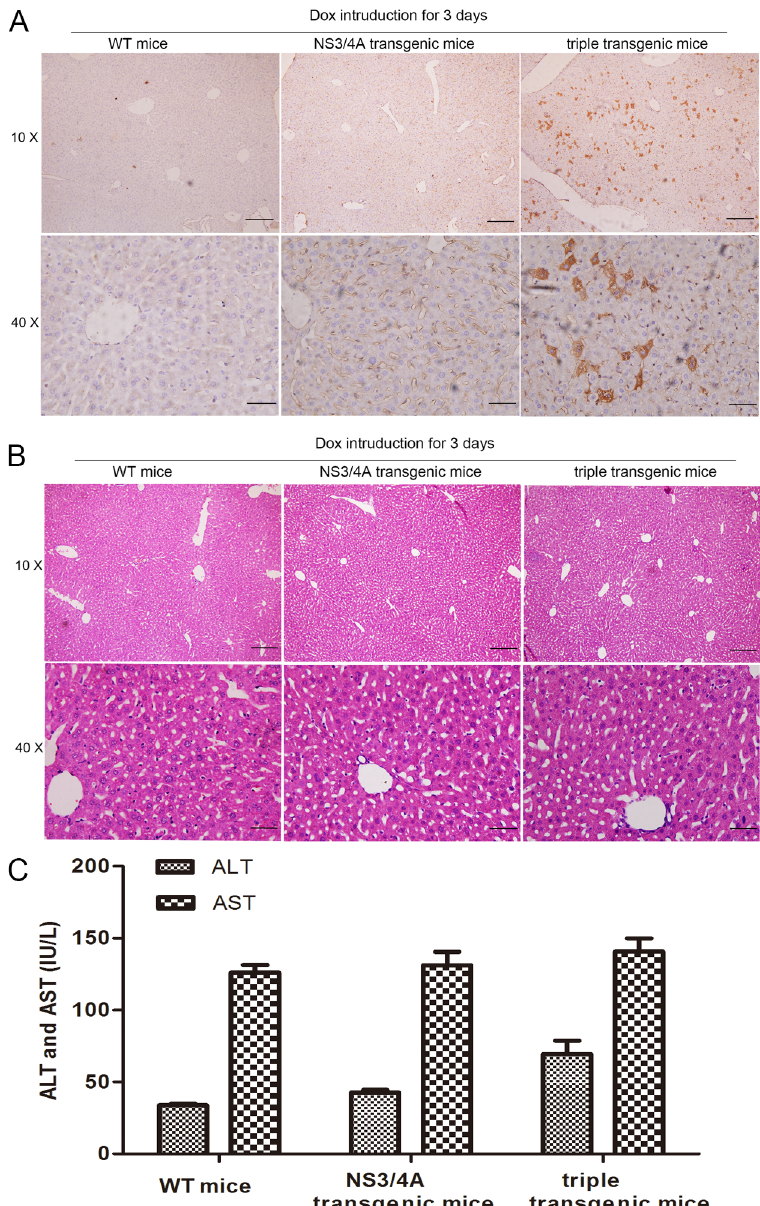
Fig 4. Liver damage caused by NS3/4A protease expression in the triple-transgenic mice. (A) Representative image of immunohistochemical staining of the NS3/4A protease in liver tissue sections from a representative WT mouse (left column), NS3/4A transgenic mouse (middle column) and triple-transgenic mouse (right column). The mice were induced with Dox for 3 days (1 mg/mL Dox and 50 g/L sugar were dissolved in their drinking water). The slides were counterstained with H&E. The upper images were taken at 10X magnification (scale bars, 200 μ m). The lower images were taken at 40 X magnification (scale bars, 50 μ m). (B) Histological examination of tissue damage. Liver sections from a representative WT mouse (left column), NS3/4A transgenic mouse (middle column) and triple-transgenic mouse (right column) following induction with Dox for 3 days. The sections were stained with H&E. The upper images were taken at 10 X magnification (scale bars, 200 μ m). The lower images were taken at 40 X magnification (scale bars, 50 μ m). (C) Analysis of serum ALT and AST levels in WT mice, NS3/4A transgenic mice and triple-transgenic mice following induction with Dox for 3 days (n = 10).